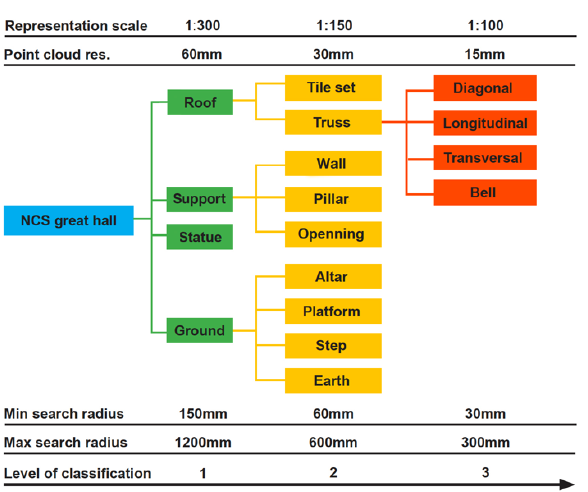
Figure 3. Classes of the point cloud for NCS project.